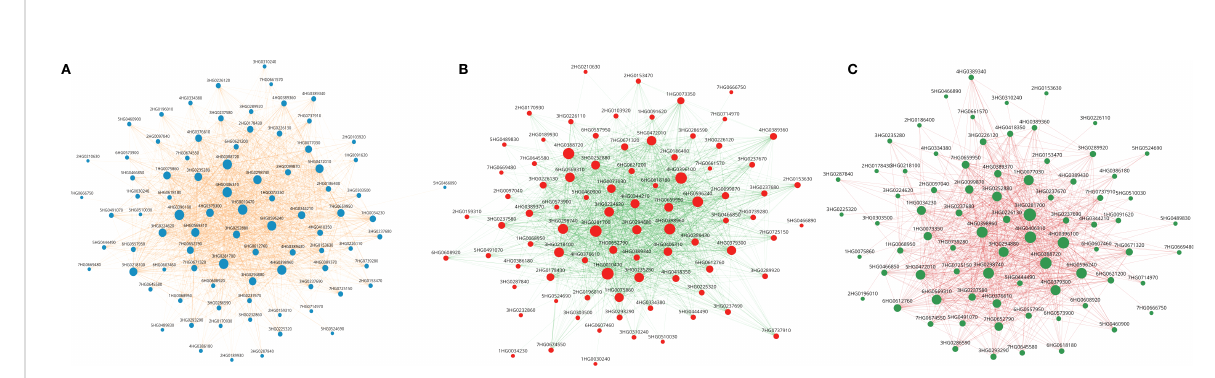
FIGURE 10 (A) Gene networks for 102 DEGs involved under heat and drought stress in the Dark red module (108 genes). Size of the node represent the degree. All genes ’ nodes are represented in blue color while edges are represented by tan color. (B) Gene networks for 87 DEGs in response to heat stress in the Dark red module (108 genes). Size of the node represent the degree. All genes are represented in tomato color while edges are represented by green color. (C) Gene networks for 42 DEGs involved under drought stress in the Dark red module (108 genes). Size of the node represent the degree. All genes are represented in green color while edges are represented by pink color.